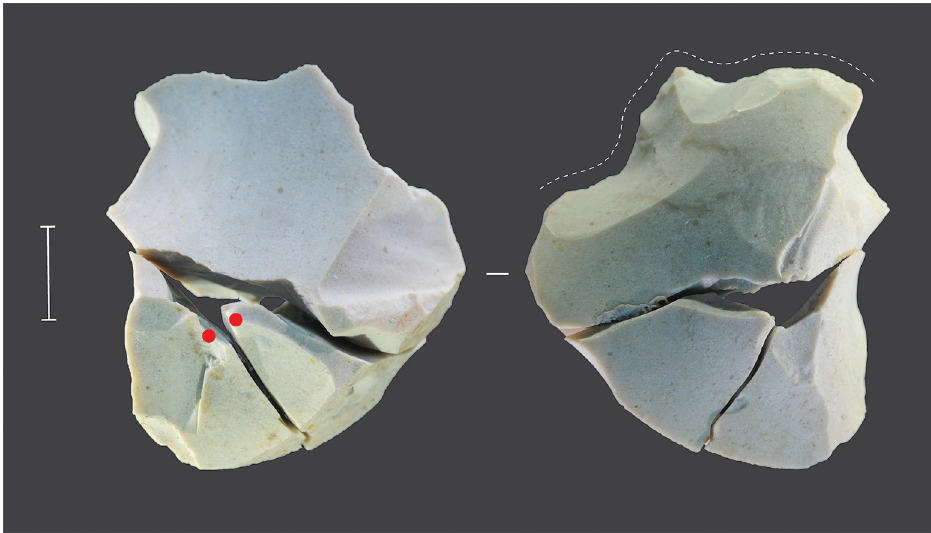
Fig 19. Conjoined set of truncated pieces, Horizon IV, Saruq al-Hadid. The ventral surface of the flake blank is shown on the right. Reduction began with unifacial freehand retouching to the blank’s ventral surface (indicated by the dotted line), and part of the edge shows microflaking, probably from use. This was followed by a series of anvil- supported truncations blows to the dorsal surface, culminating in the detachment of two conjoining truncation flakes. The points of force application for these two blows are shown by red dots. From context 2022, single reduction event (SRE) 32. Scale bar 10